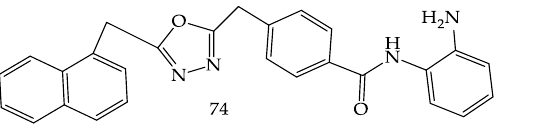
Figure 18. N-(2-Aminophenyl)-4-((5-(naphthalen-1-ylmethyl)-1,3,4-oxadiazol-2-yl)-methyl) ben- zamideas HDAC inhibitor .